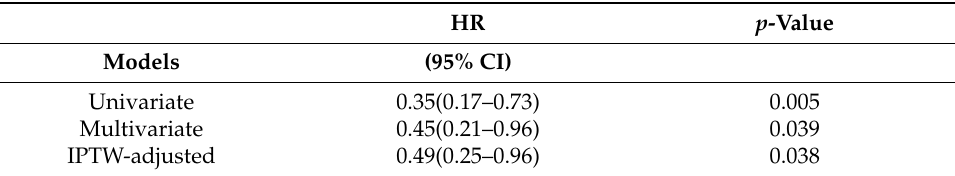
Table 4. Impact of canagliflozin on readmission for HF at first year by conventional and IPTW- adjusted Cox regression analysis.